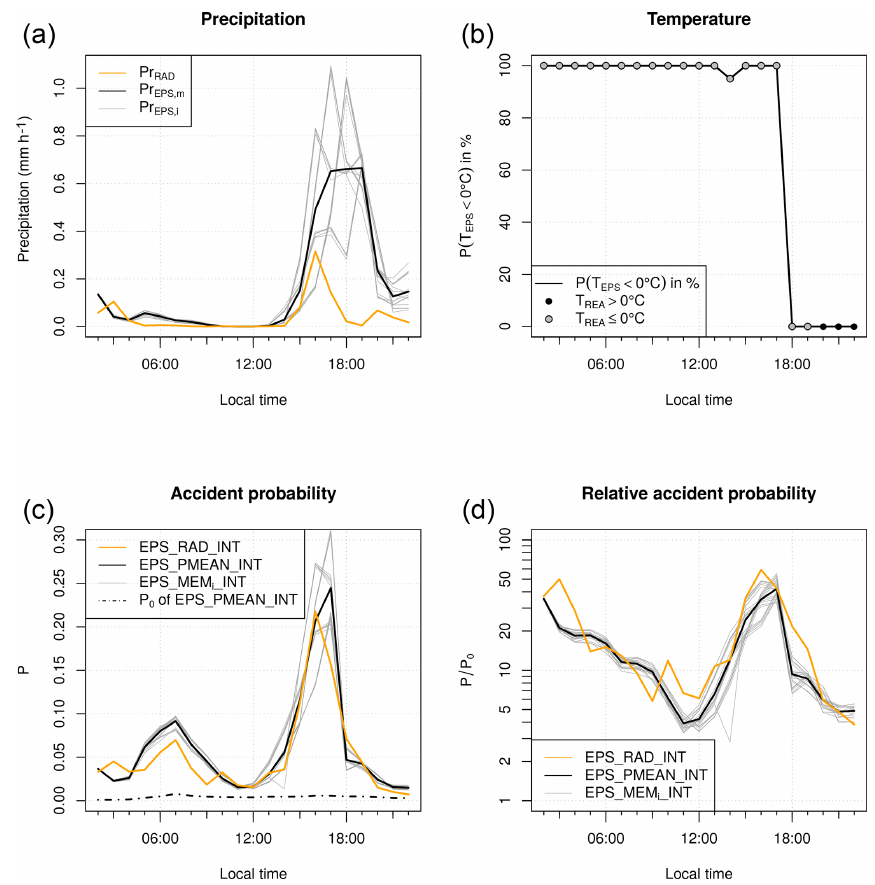
Figure 5. Application of the models EPS_RAD_INT and EPS_PMEAN_INT to an adverse winter weather event on 3 December 2012. Time series are shown for the district of Stuttgart using the COSMO-DE-EPS forecast initialized at 00:00UTC. (a) Hourly precipitation aggregated to district level, (b) percentage of ensemble members with temperatures below 0 ◦ C, (c) probability of weather-related road accidents and (d) relative accident